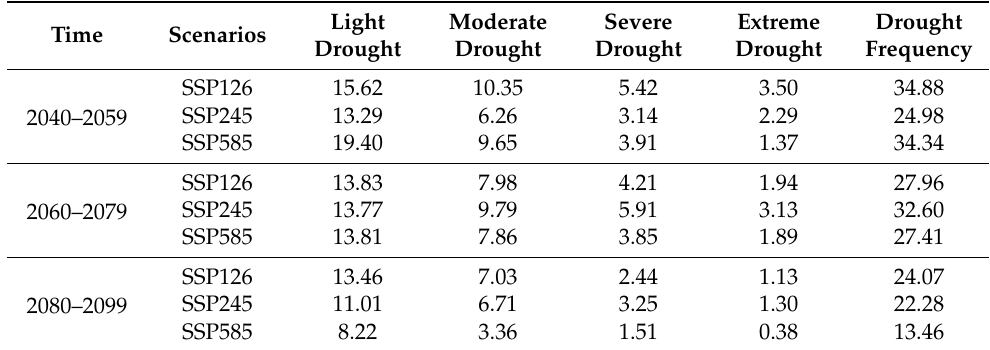
Table 5. The average probability of drought events on different grades for SSP126, SSP245, and SSP585 in the future over the Yellow River Basin; the unit is